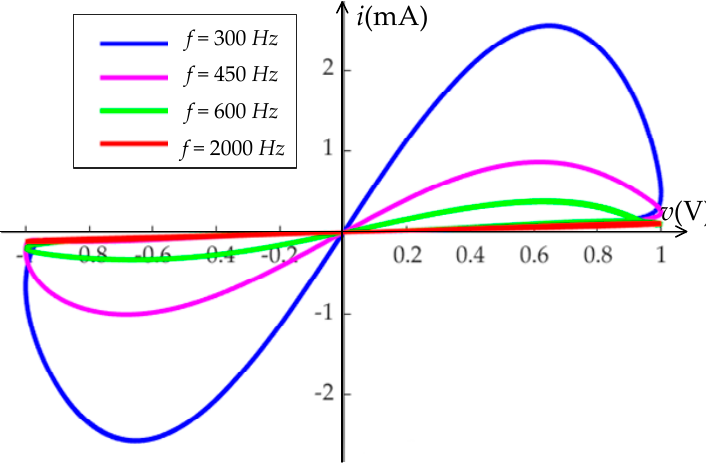
Figure 2. Memristor-pinched hysteresis loop .